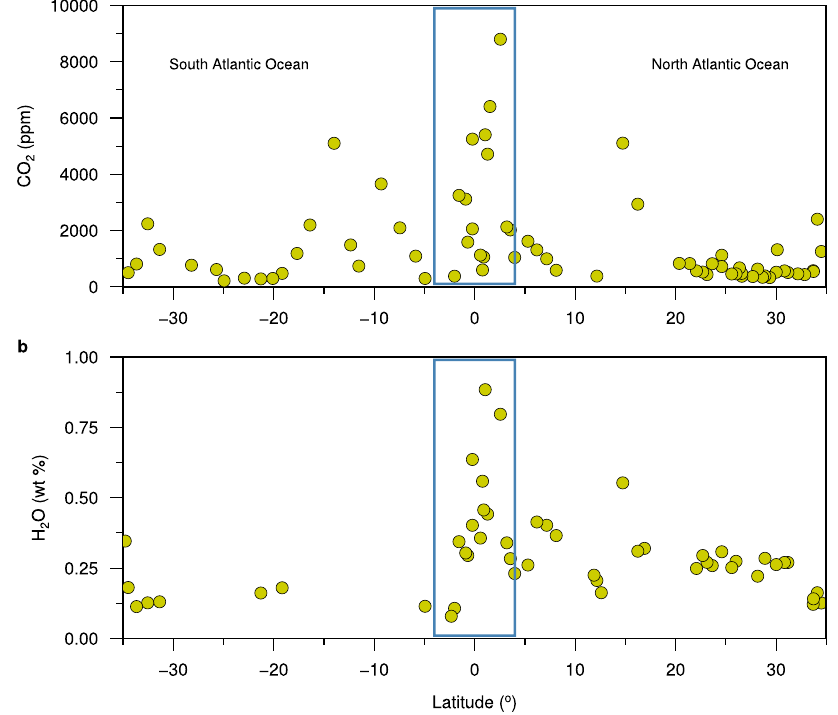
Fig. 9 | CO 2 and H 2 O concentrations along the Mid-Atlantic ridge (MAR). Segment-averaged primary magma ( a ) CO 2 and ( b ) H 2 O concentrations along the MAR between 35 o S and 35 o N. The blue boxes outline our study region in the equatorial Atlantic Ocean. Data are from ref.